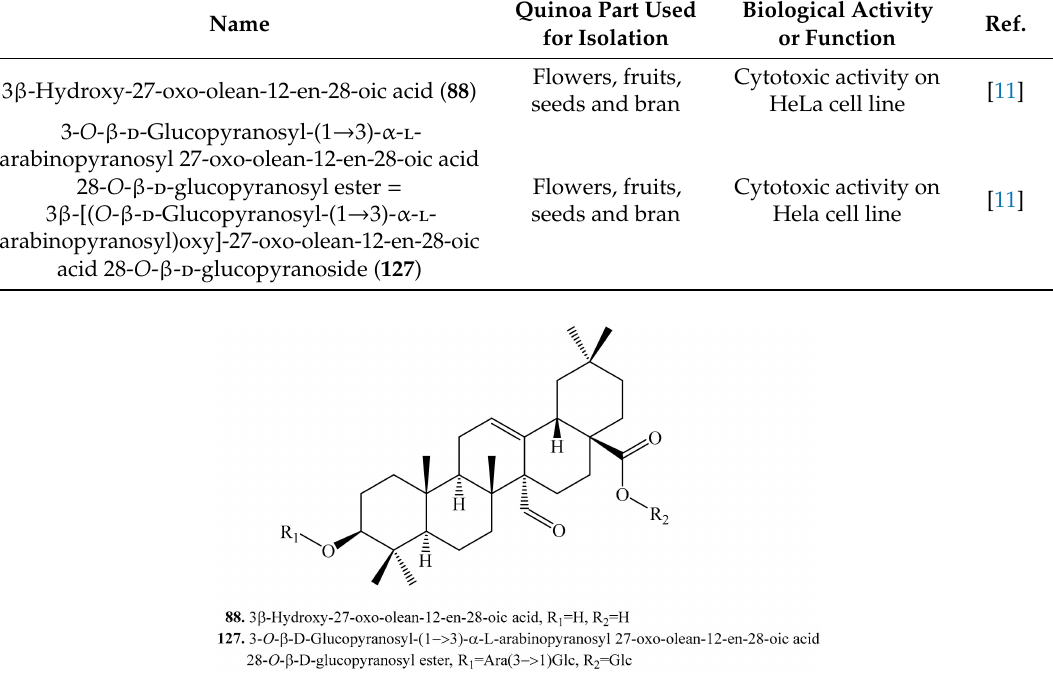
Figure 17. Structures of the 3 β -hydroxy-27-oxo-olean-12-en-28-oic acid triterpenoids isolated from